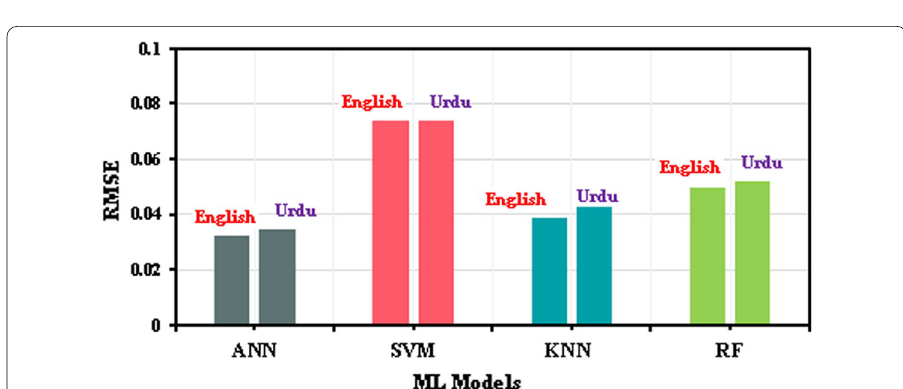
Fig. 7 The RMSE of the classification models with TFCV for English and Urdu